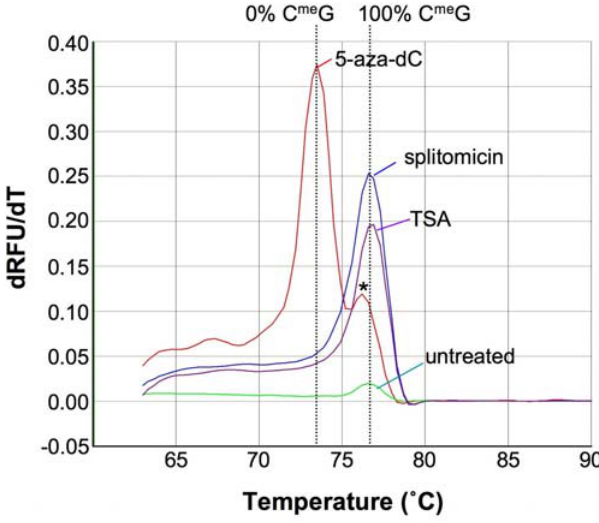
Figure 7. The effect of treatment with 5-aza-dC, splitomicin and TSA on the DNA methylation of the promoter of a FXS allele. Lymphoblastoid cells from a FXS patient were treated with the indicated compounds as described in the Materials and Methods. Genomic DNA isolated from cells with and without treatment was tested for DNA methylation at the FMR1 promoter. The derivative of the dissociation curve of the bisulfite modified PCR fragment obtained from this procedure (dRFU/dT) was plotted as a function of temperature. The point of inflection corresponds to the Tm of the PCR product. Note that 2 peaks in the 5-aza-dC-treated samples are seen, one corresponding to completely demethylated alleles and a much smaller one, indicated by an asterisk, reflecting residual partially methylated alleles. RFU: relative fluorescent units.